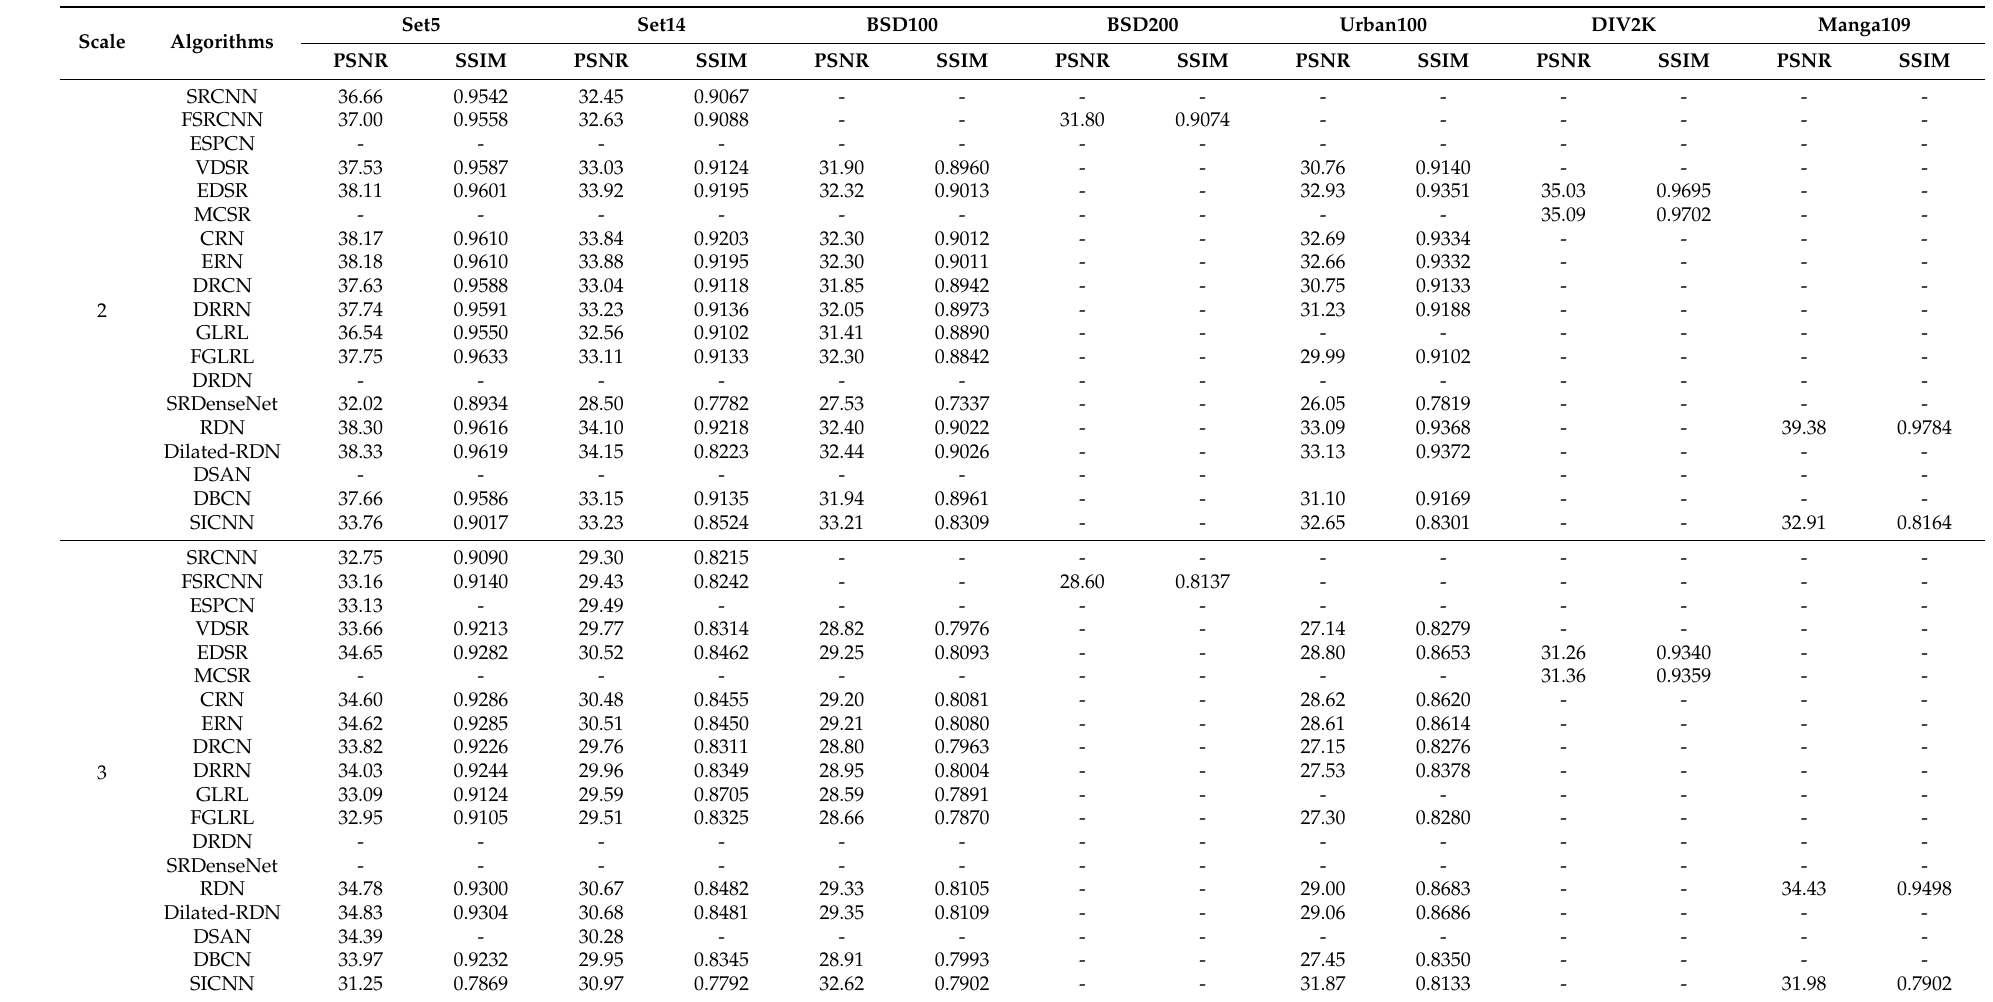
Table 4. Mean PSNR and SSIM for each of the algorithms. The “-” indicates no result found in the